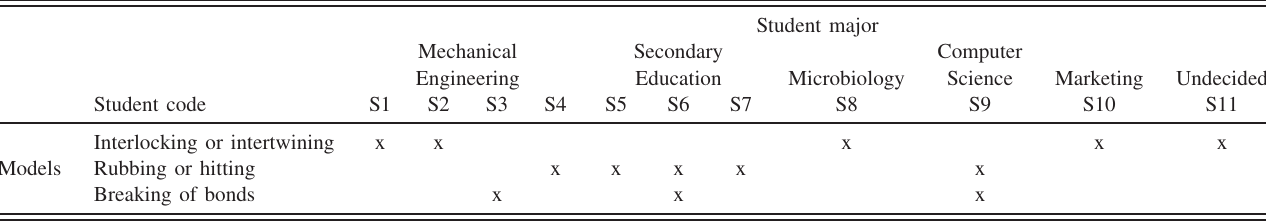
TABLE II. Models used in explaining friction as per student’s major.